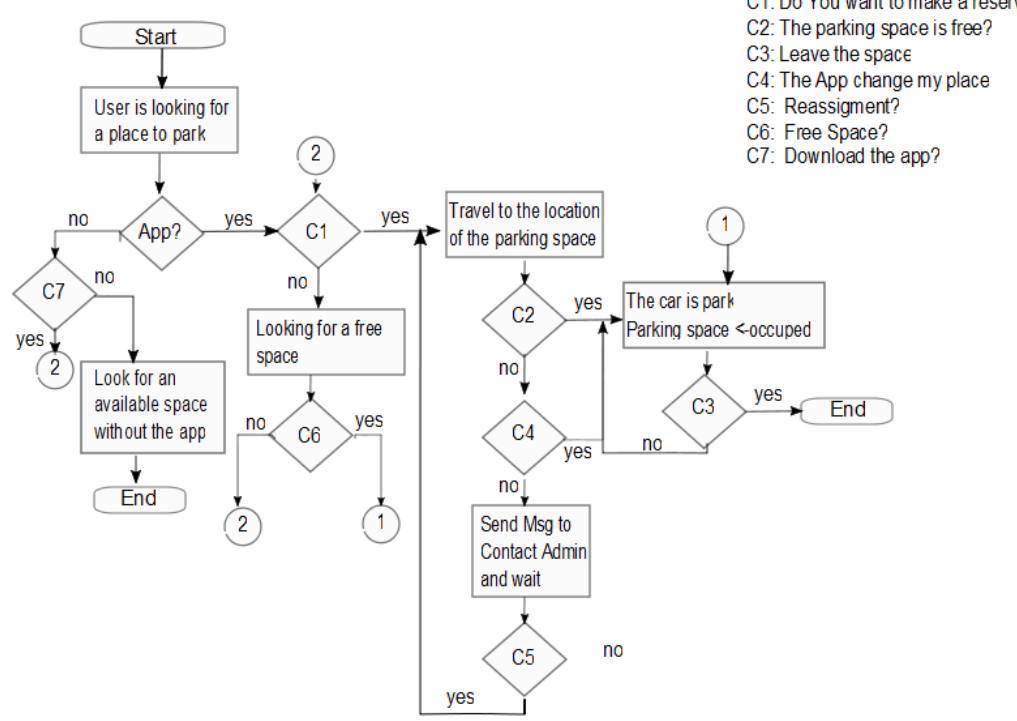
Figure 4. Flow diagrams that represent the user/driver